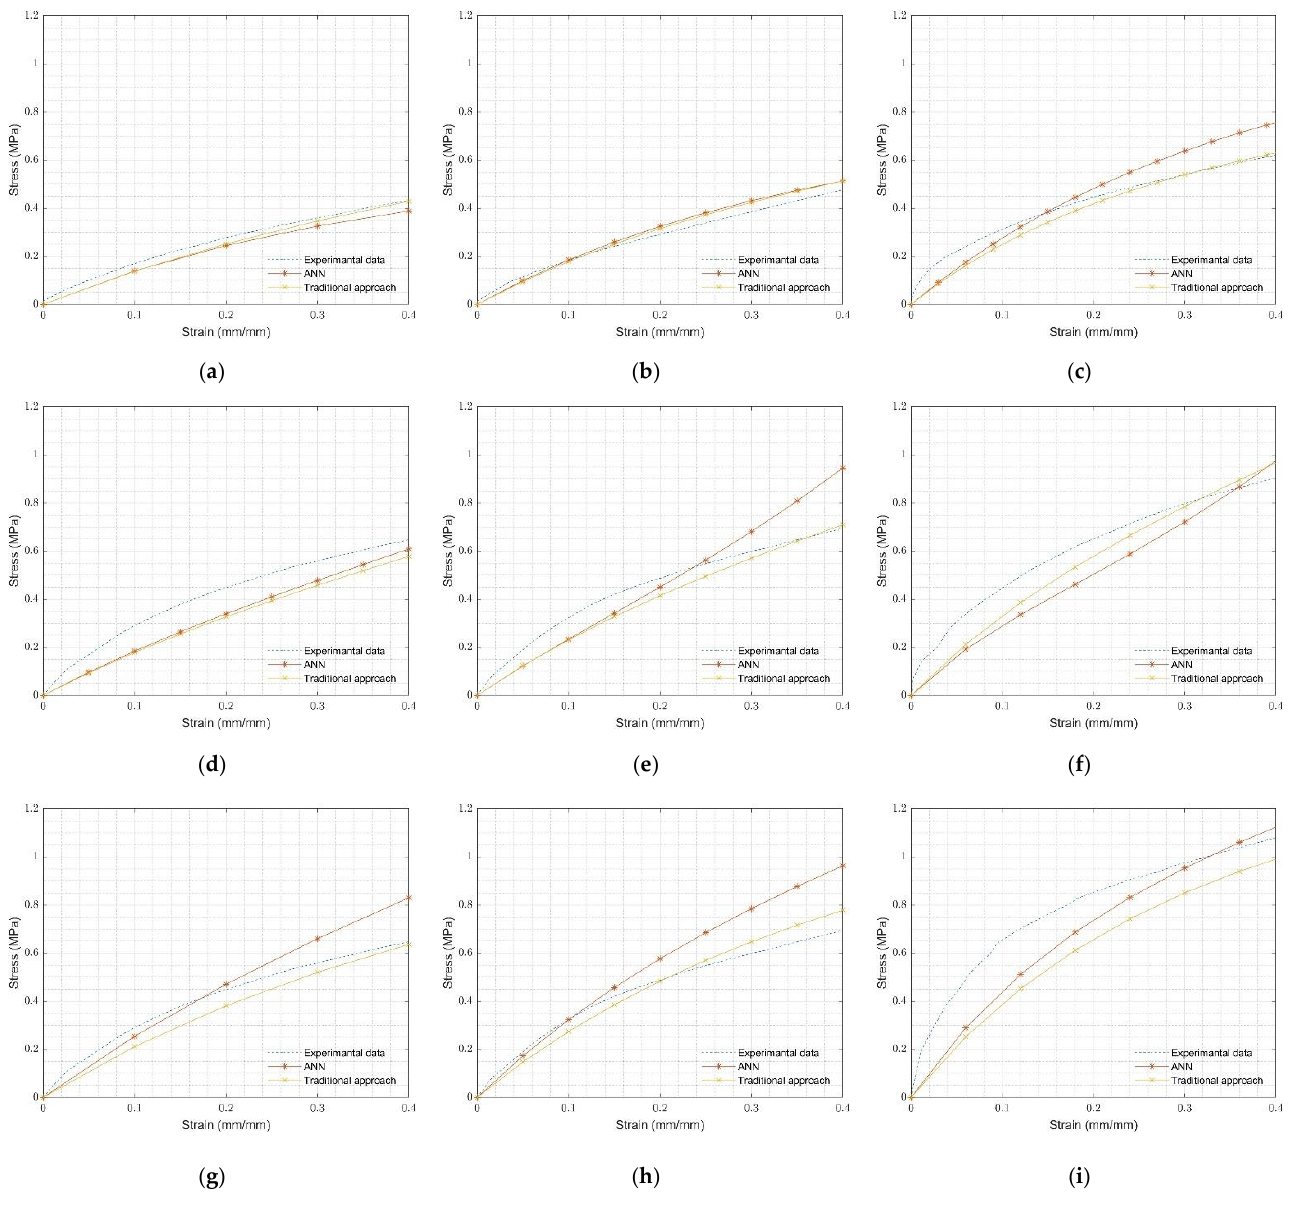
Figure 13. Comparison of experimental and FEA results of coupon tests: ( a ) neoprene rubber uniaxial test, ( b ) neoprene rubber planar test, ( c ) neoprene rubber equibiaxial test, ( d ) natural rubber uniaxial test, ( e ) natural rubber planar test, ( f ) natural rubber equibiaxial test, ( g ) silicone rubber uniaxial test, ( h ) silicone rubber planar test, and ( i ) silicone rubber equibiaxial test.